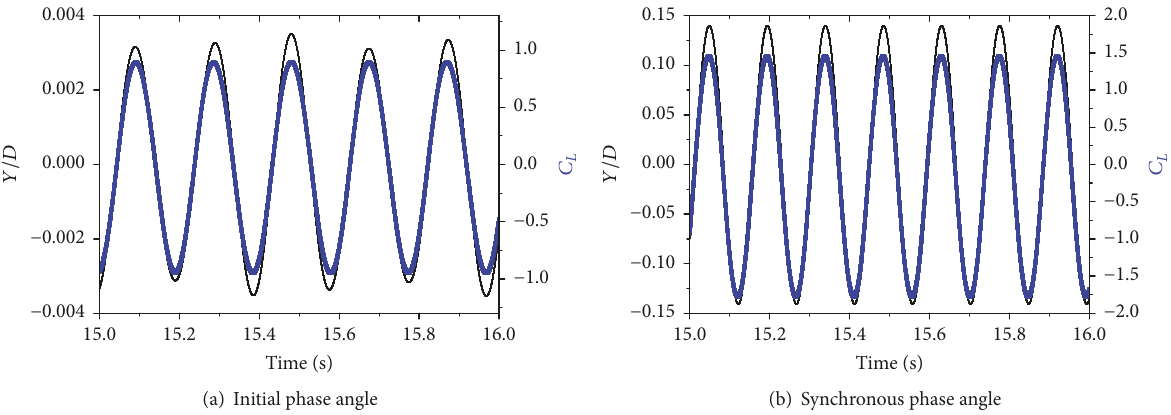
Figure 13: Results of phase angle in initial and synchronization state for 𝛼 = 15 ∘ / 𝛼 = 75 ∘ .